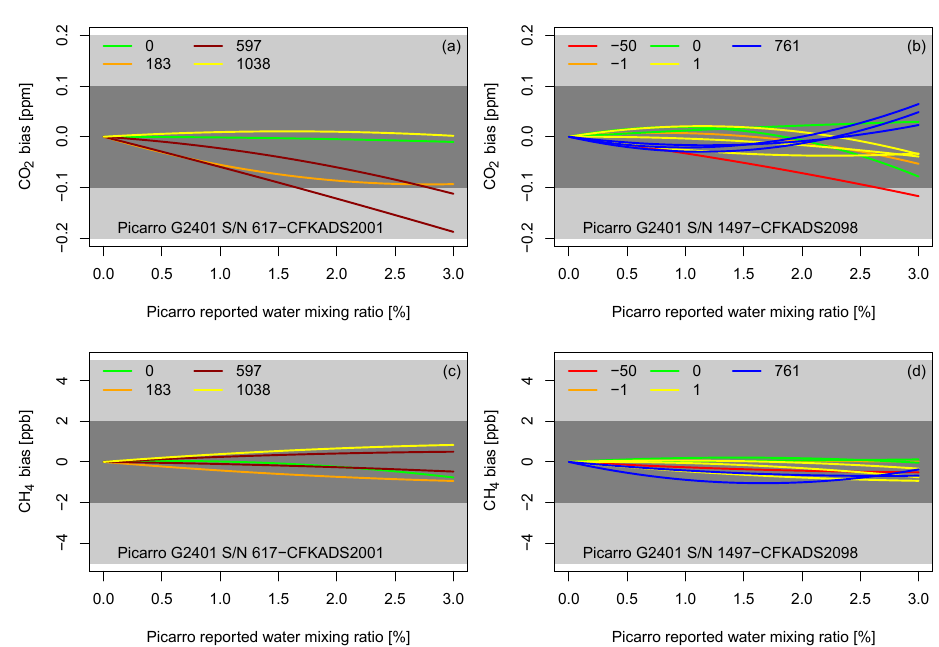
Figure 14. (a) Bias at 400ppm CO 2 compared to initial correction function of the Picarro G2401 S/N 617-CFKADS2001. The different lines correspond to the individual determinations of the correction functions. The number in the legend refers to the number of days from the determination of the reference correction function. (b) Same as (a) , for Picarro G2401 S/N 1497-CFKADS2098. ( c and d ) Same as ( a and b ), for CH 4 at 1900ppb. The grey areas correspond to the WMO/GAW compatibility (dark grey) and extended compatibility (light grey) goals.